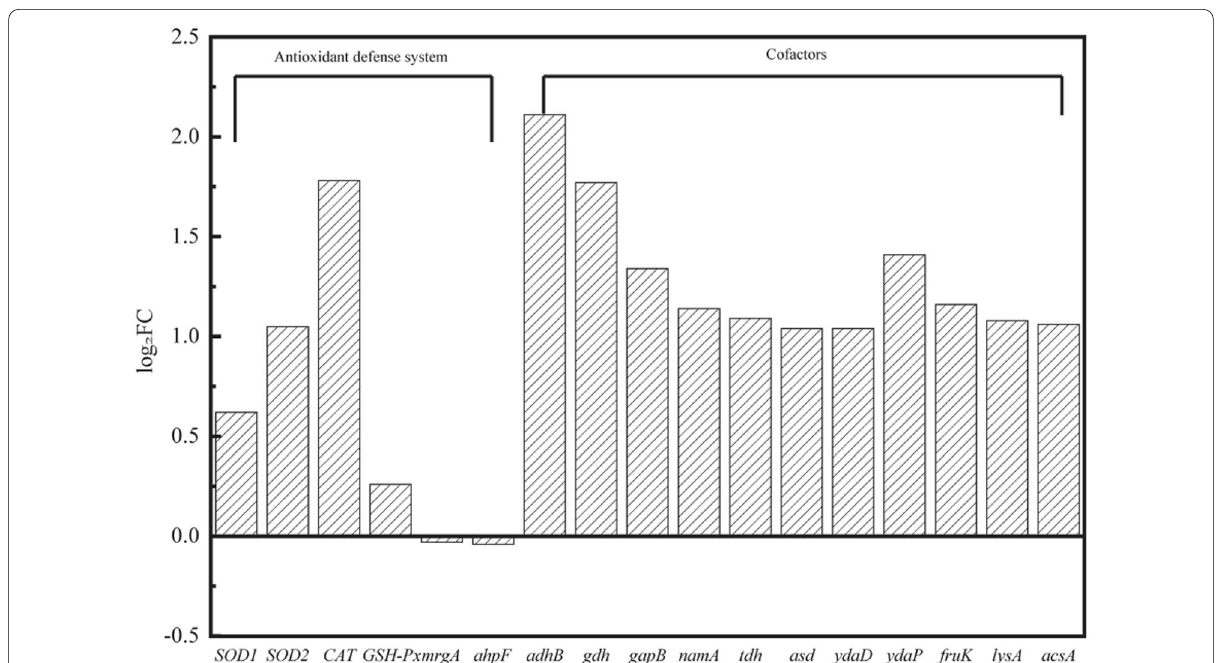
Fig. 6 Changes in transcript abundance of genes involved in antioxidant defense system and NADH generating enzymes in ALE-25–40. SOD1/ SOD2 superoxide dismutase, CAT vegetative catalase 1, GSH-Px glutathione peroxidase, mrgA metalloregulation DNA-binding stress protein, ahpF alkyl hydroperoxide reductase large subunit and NADH dehydrogenase, adhB alcohol dehydrogenase, gdh glucose-1-dehydrogenase, gapB glyceraldehyde-3-phosphate dehydrogenase, namA NADPH dehydrogenase namA, tdh l -threonine 3-dehydrogenase, asd aspartate–semialdehyde dehydrogenase, ydaD short-chain dehydrogenase, ydaP pyruvate oxidase, fruK fructose-1-phosphate kinase, lysA diaminopimelate decarboxylase, acsA acetyl-CoA